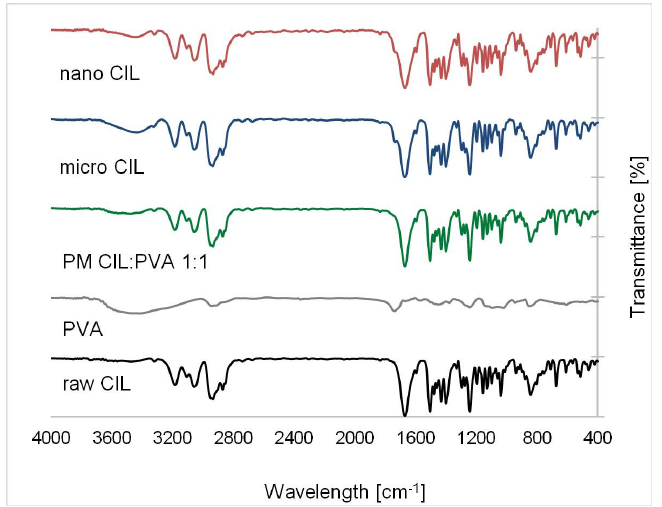
Figure 15. Fourier-transformed infrared (FTIR) spectra of unprocessed cilostazol, PVA, physical mixture (PM) and micro- and nanocrystals.